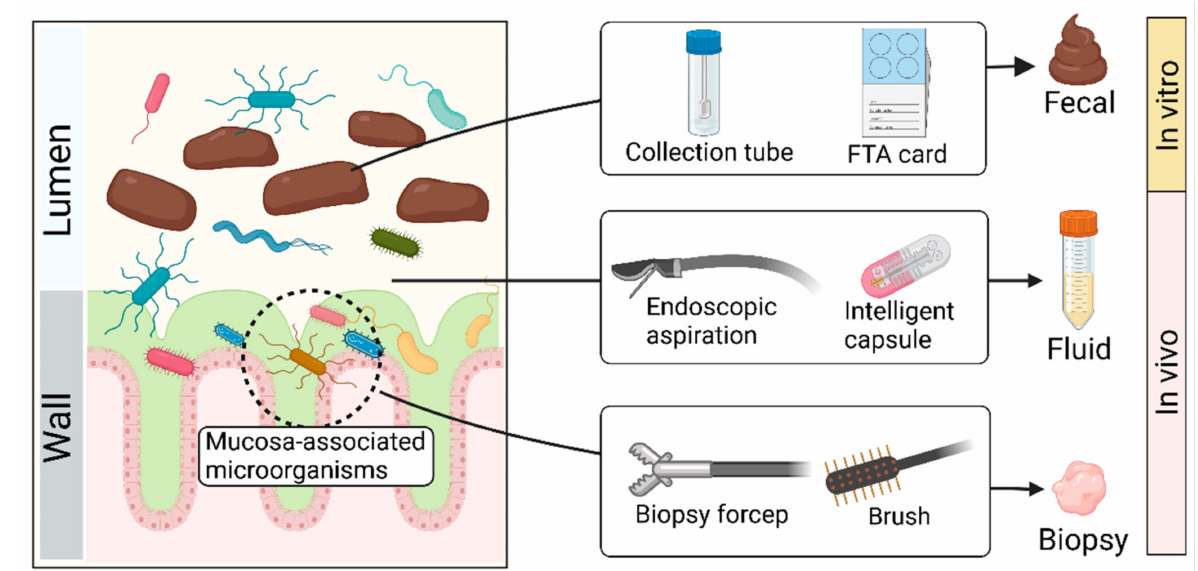
Figure 2. Schematic diagram of sample collection. Created with